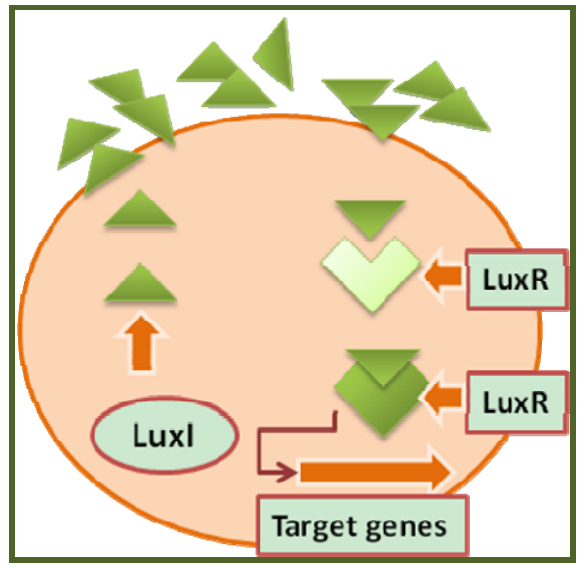
Figure 1. A typical quorum-sensing system in Gram-negative